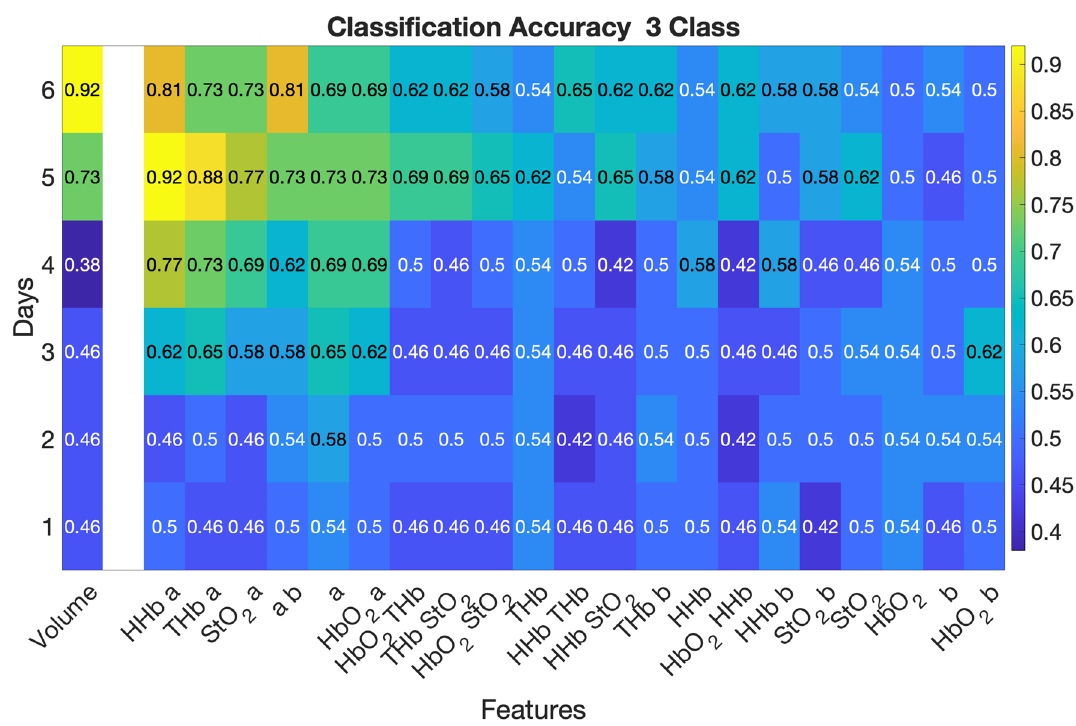
Figure 4. Short term classification accuracy feature selection. Linear discriminant analysis was conducted on the short-term cohort (through Day 6) for all 3 treatment groups (Control, CPA, and CPA + Ab). The classification accuracy for each timepoint and feature is displayed in text and indicated by shading for each metric at each timepoint. The combination of the SFDI parameters ctHHb and a provided higher classification accuracy than tumor volume on days 3, 4, and